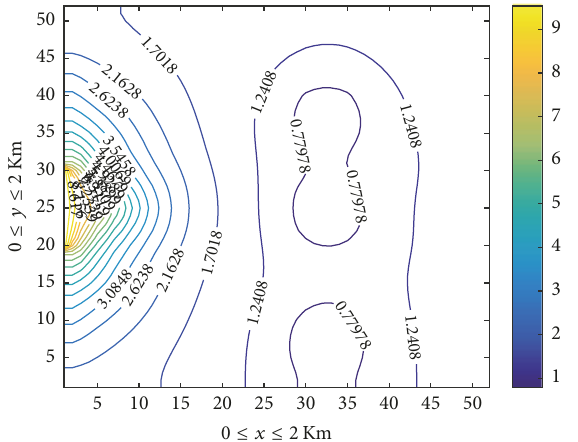
Figure 16: The overall approximated pollutant concentrations when the eastern exit gate is opened on the period 33–100 min.